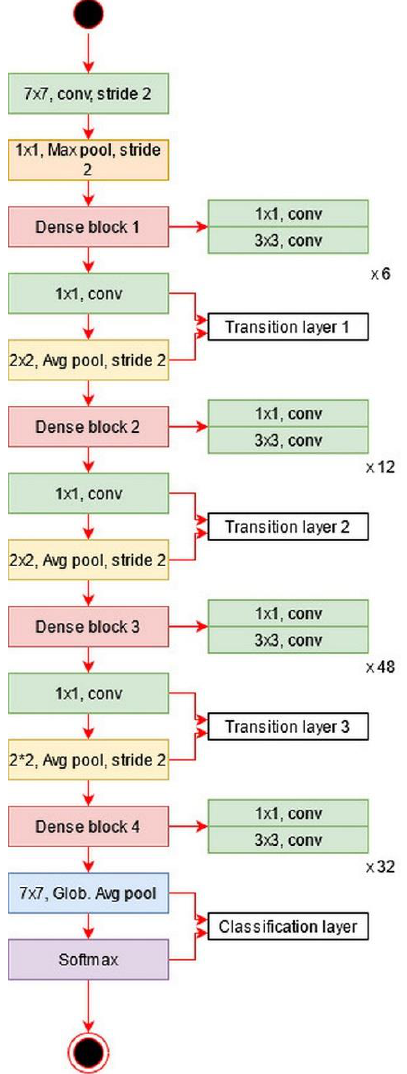
Figure 13. Architecture of DenseNet201 deep learning model.